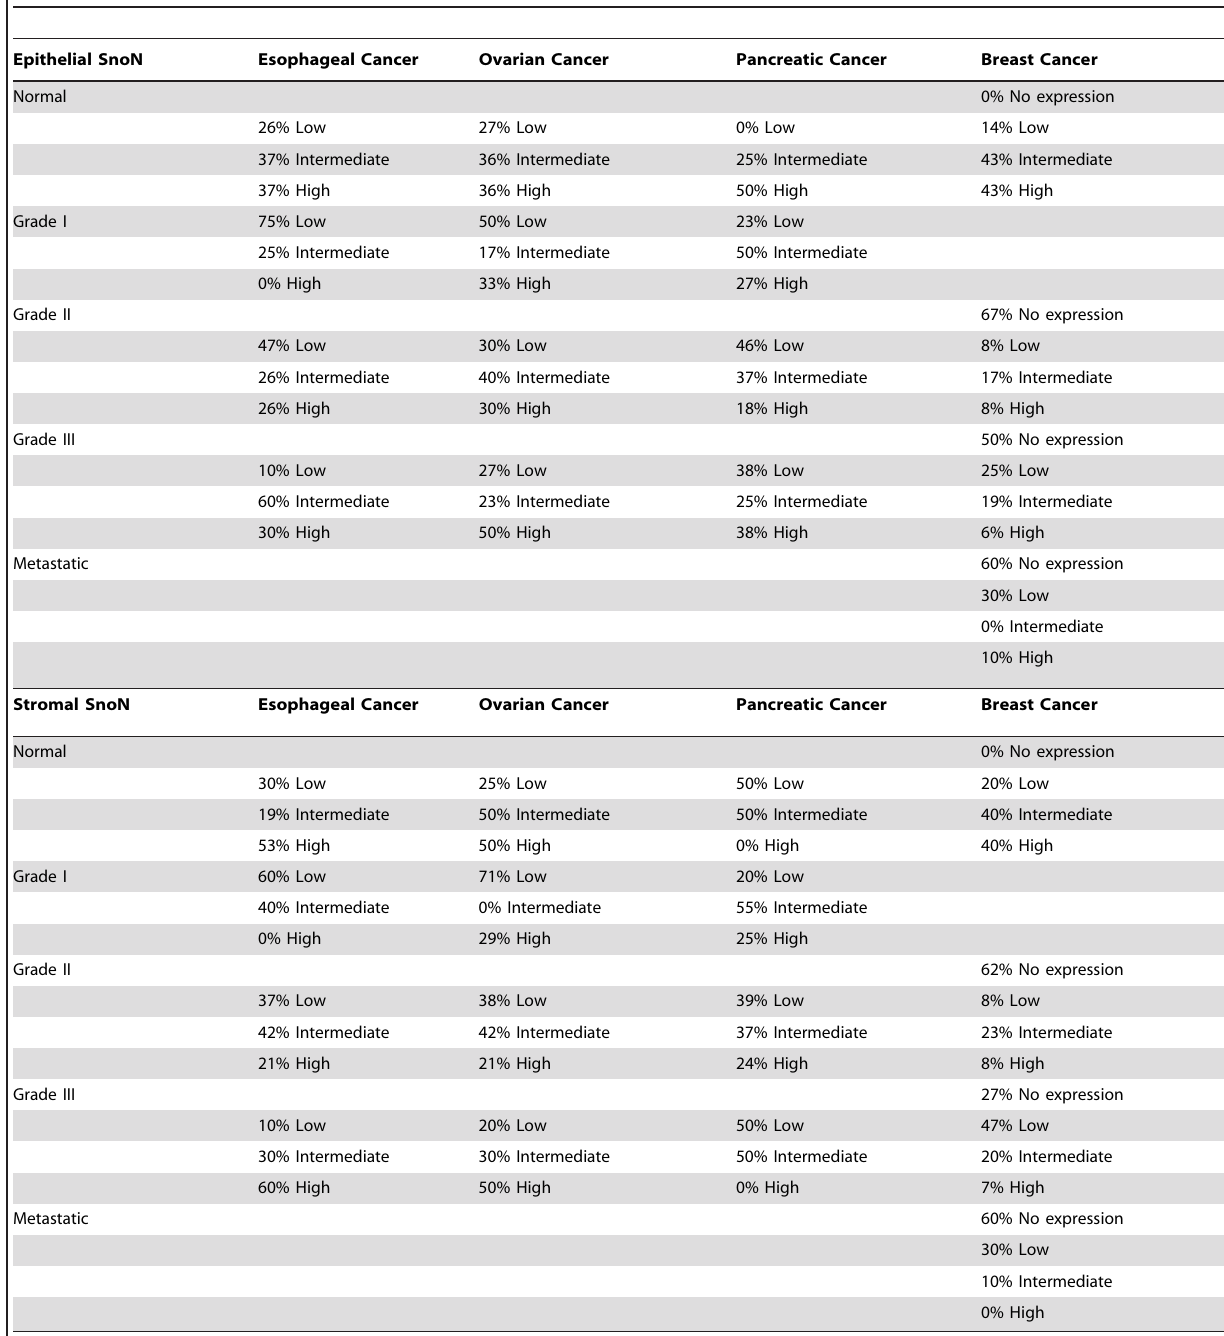
Table 1. Summary of SnoN expression levels (percentages with no expression, low, intermediate, and high) for each grade within different tumor arrays in both the epithelial and stromal compartments.